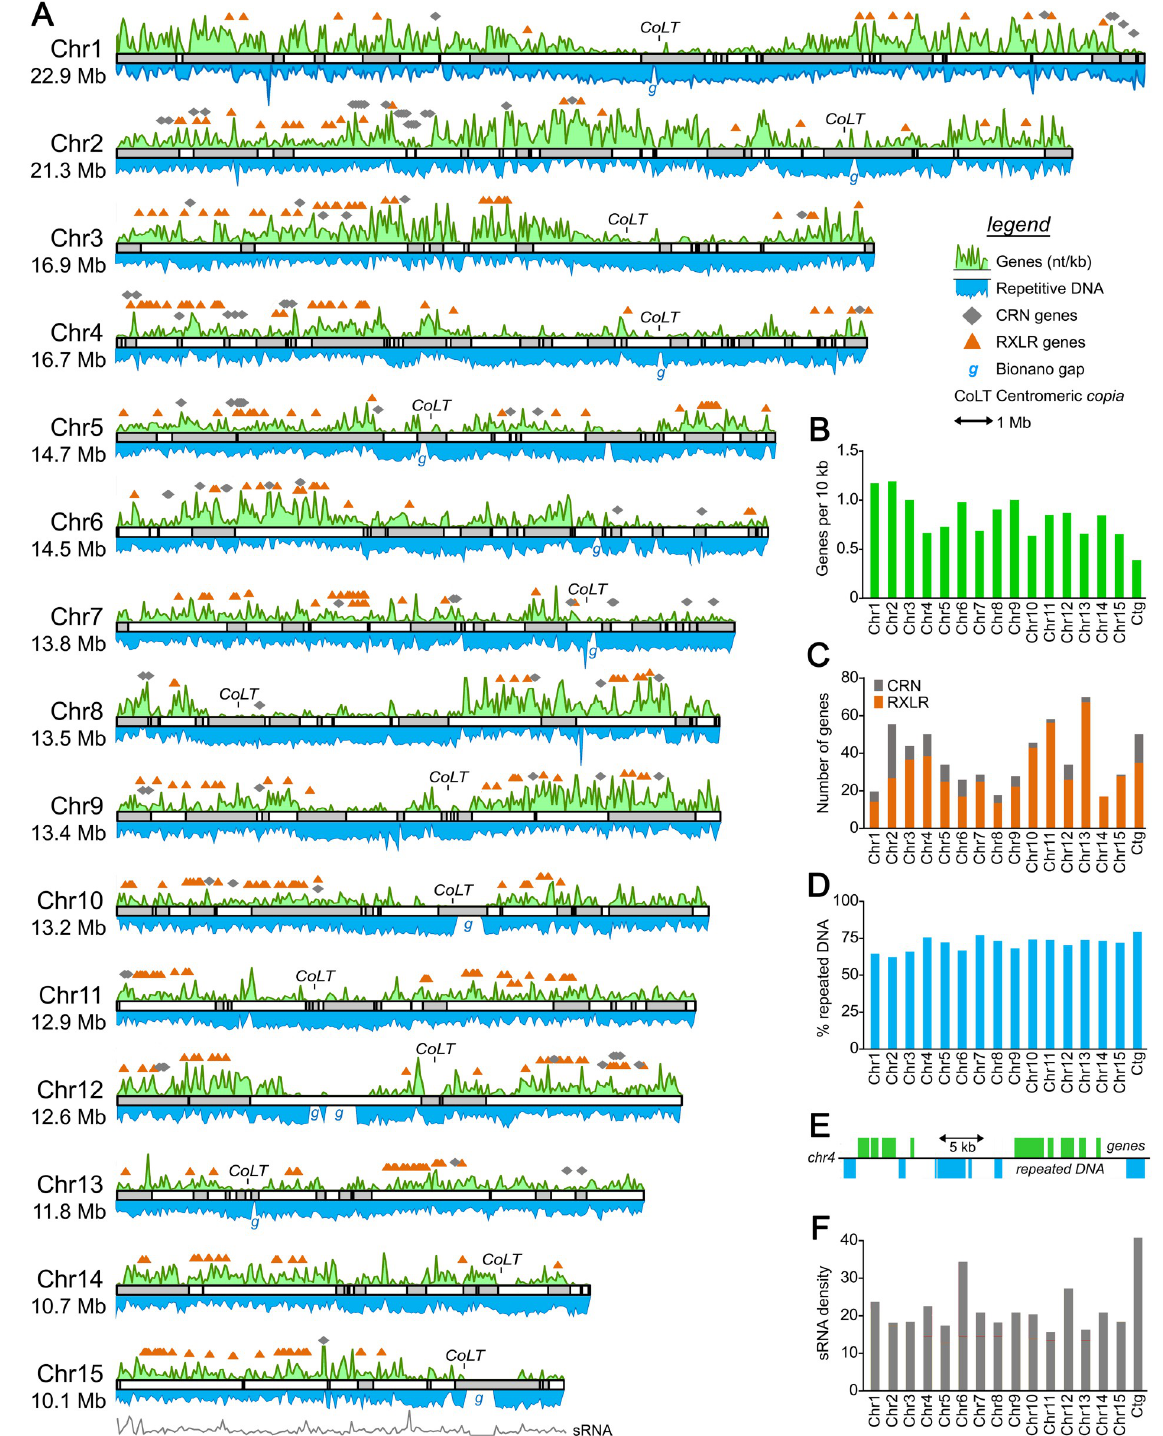
Fig 2. Structure of P . infestans chromosomes. A , Maps of the chromosomes, with contigs from the Stitch7 assembly shown as alternating white and grey blocks. Each chromosome (Chr prefix) is marked along with its predicted size in Mb. The green and blue curves above and below each chromosome map represent the relative density of genes and repeats, respectively, as nt per kb. Positions of effector genes are shown above each chromosome, with RXLRs and CRNs represented by orange triangles and grey diamonds, respectively. Clusters of the copia -like element associated with centromeres are marked as CoLT , and gaps predicted by the Bionano optical map are marked as g . The grey